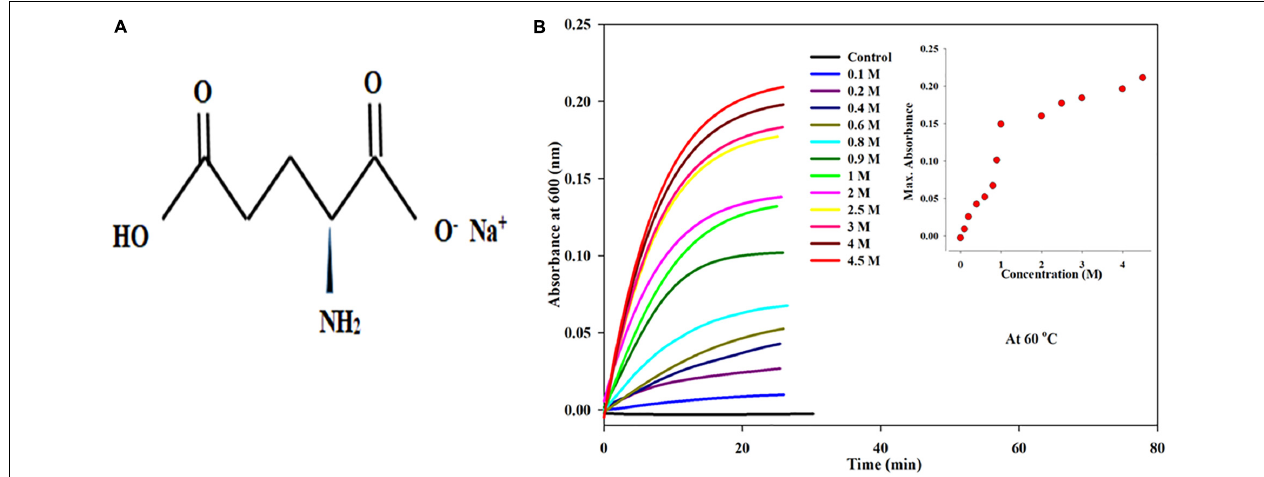
FIGURE 1 | (A) Chemical structure of monosodium glutamate (MS). (B) Kinetic measurements of BSA in presence increasing concentrations of monosodium glutamate (0.1 to 4.5 Molar) at 60 ◦ C temperature, 25 mM phosphate buffer, pH. 7.0 and 600 nm. Inset of Figure 1 inset shows the influence of concentration on ( A max ) maximum absorbance of MSG-induced BSA aggregation at 60 ◦ C